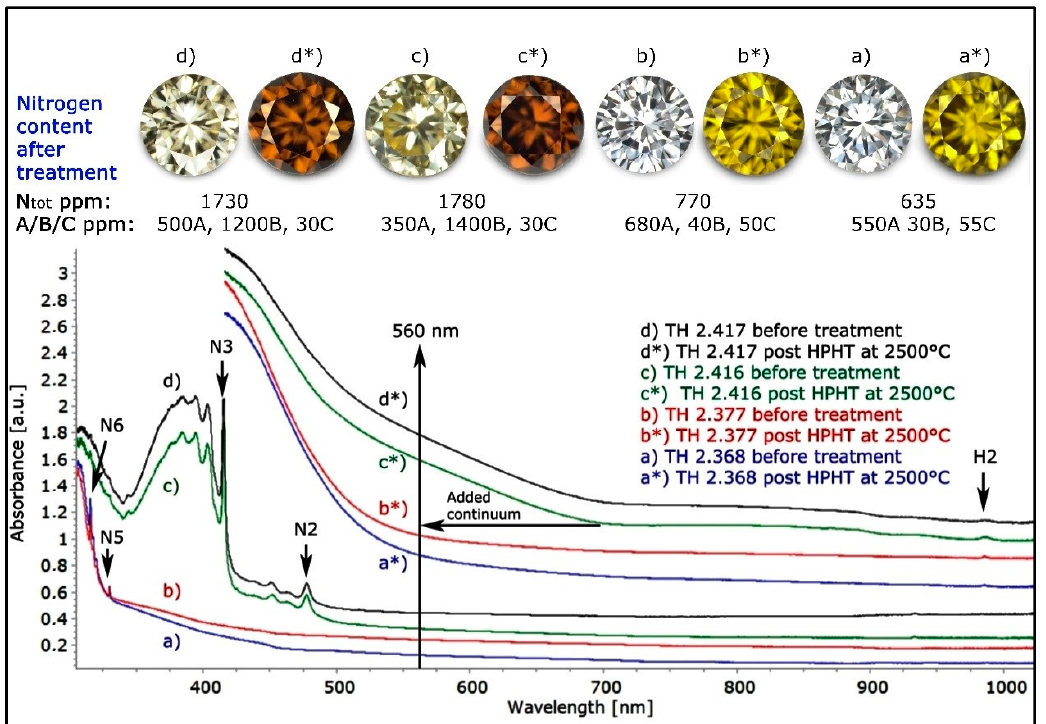
Figure 30. The low temperature UV-Vis-NIR spectra of four cape type IaAB diamonds that were HPHT processed at 2500 °C. Samples TH 2.416 and TH 2.417 were light yellow before the treatment and turned orangey brown by HPHT while the other two diamonds were perfectly colorless before the treatment and turned vivid yellow by HPHT. The only analytical difference between the diamonds was the relative ratio of A to B aggregates and total nitrogen content, which leads in consequence to the much higher N3 concentration in the yellowish samples. After the treatment the diamonds rich in N3 centers developed the additional continuum absorption starting at 700 nm and neither N3 nor N2 is detectable. The spectra have been shifted vertically for clarity.